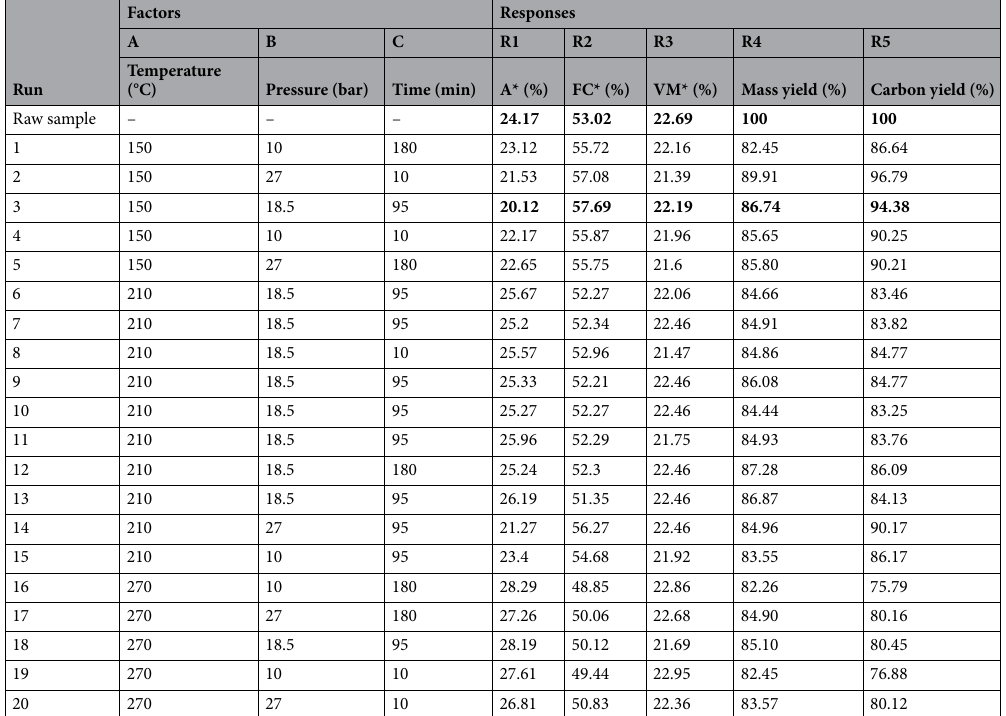
Table 4. Physicochemical analysis results of produced HC from coal slurry (CS) . Significant values are in bold. A ash content, FC fixed carbon, VM volatile matter. *Dried basis (moisture free). Solid/liquid ratio: